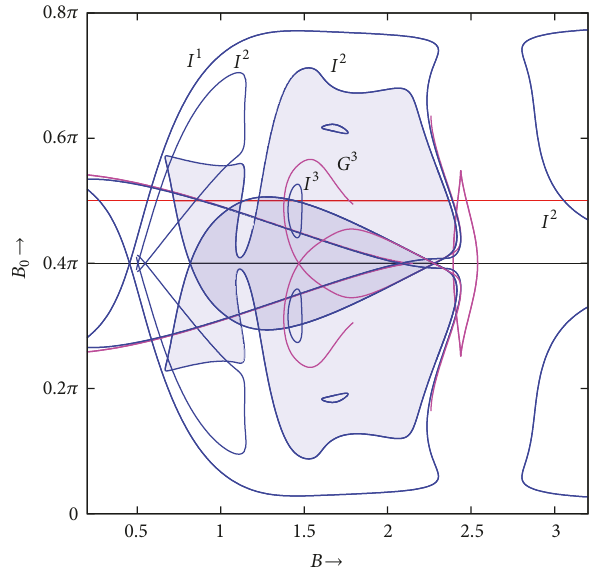
Figure 3: Bifurcation diagram of system (3) in 𝐵 - 𝐵 0 plane with 𝑓(𝑦) = 𝑓